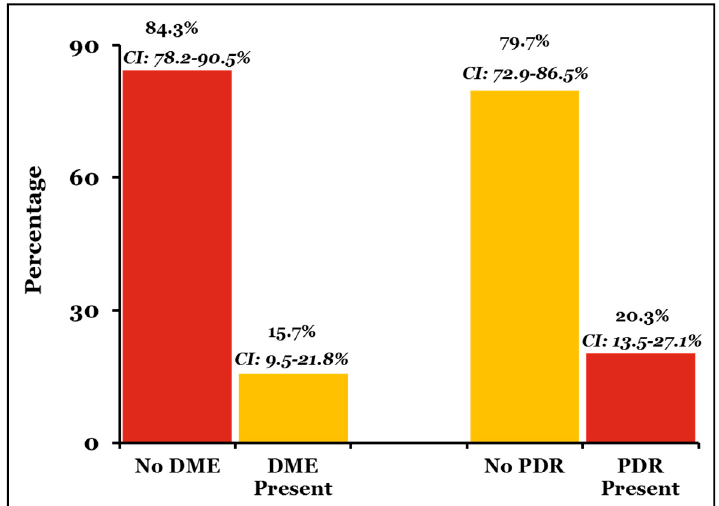
Figure 3. Based on a retrospective clinical study at the University of New Mexico, about 85% of proliferative diabetic retinopathy (PDR) patients do not have concurrent diabetic macular edema (DME), and, similarly, 80% of DME patients do not have concurrent PDR. There is no influence of systemic factor control in such a correlation.